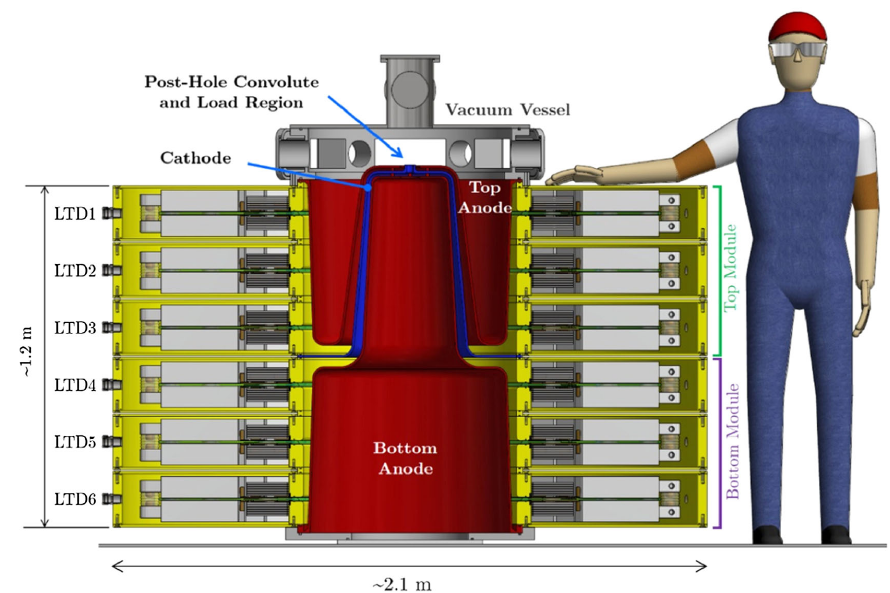
FIG. 2. A cutout view of HADES showing the location of the transmission lines (top and bottom anodes in red as well as the cathode in blue). The two modules are also shown. Each module has three identical cavities shown in Fig. 1 (yellow in this